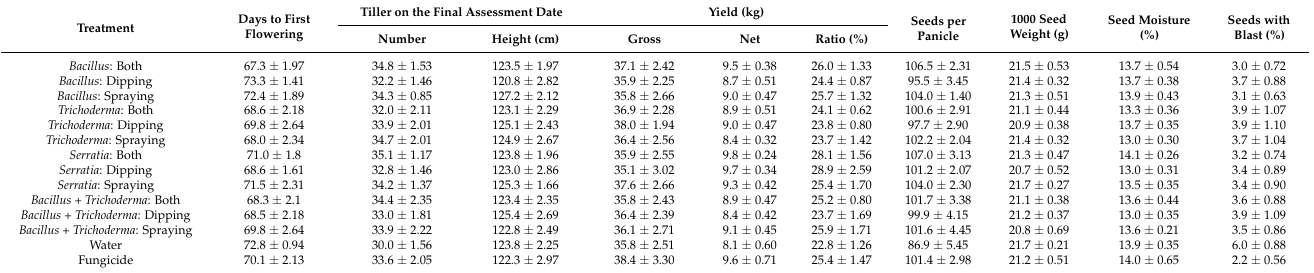
Table 1. Treatment means and standard errors; rice plants were treated with four biopesticide products in three different ways to manage rice blast. The experiment was carried out at one site in Kenya in 2020 and 2021; each mean is an average of eight independent replicates